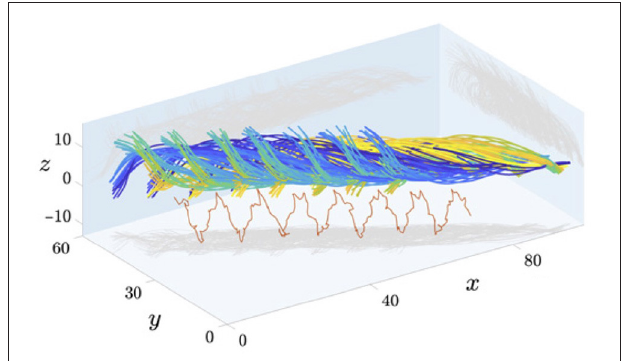
FIGURE 5 | Captured data of the 3D beating of human spermatozoa near a coverslip, with different timepoints shown in different colours. Axes have units of micrometres and a projection of the mid-flagellar point is shown in red. Figure reproduced from the work of Gadêlha and Gaffney (2019), Gadêlha et al. (2020); Shilatifard and Yeagle (2020), with permission under the terms of the Creative Commons Attribution License http://creativecommons.org/